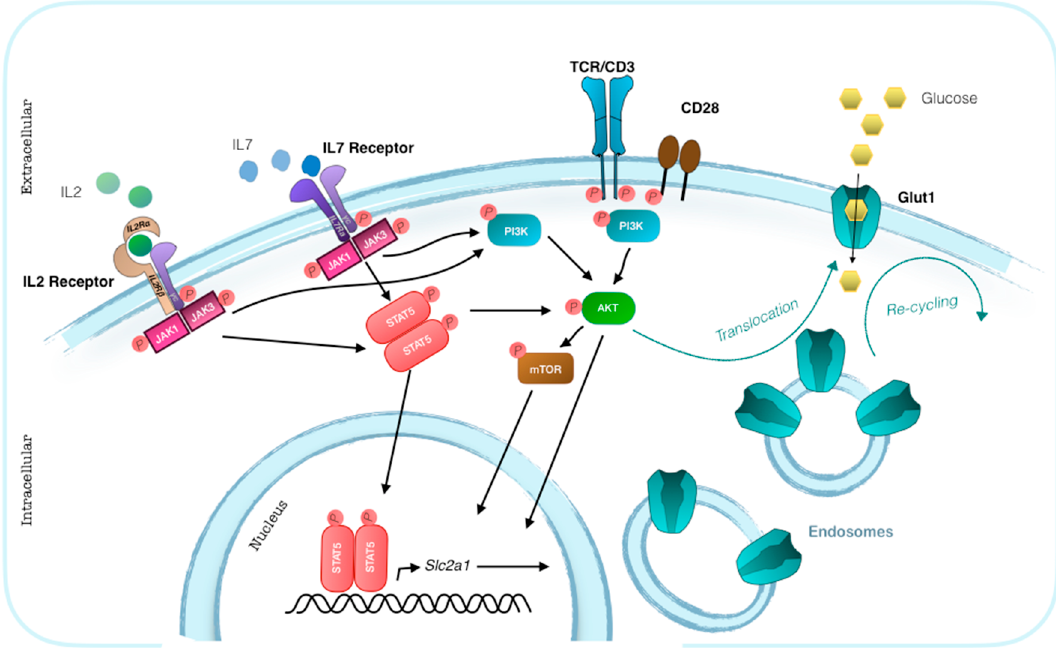
Figure 3. Glut1 expression and trafficking in T cells. The T cell surface expression of Glut 1 is regulated by extrinsic signals. The transcription of the Slc2a1 gene is induced by engagement of TCR and CD28 co-stimulation or by cytokine signaling through phosphorylated STAT5. The translocation of the intracellular pool of Glut1 to the cell surface is mainly regulated by Akt. Akt activation is the result of TCR and CD28 engagement or can be activated by phosphorylated STAT5 through the IL-2 or IL-7 signaling pathways.